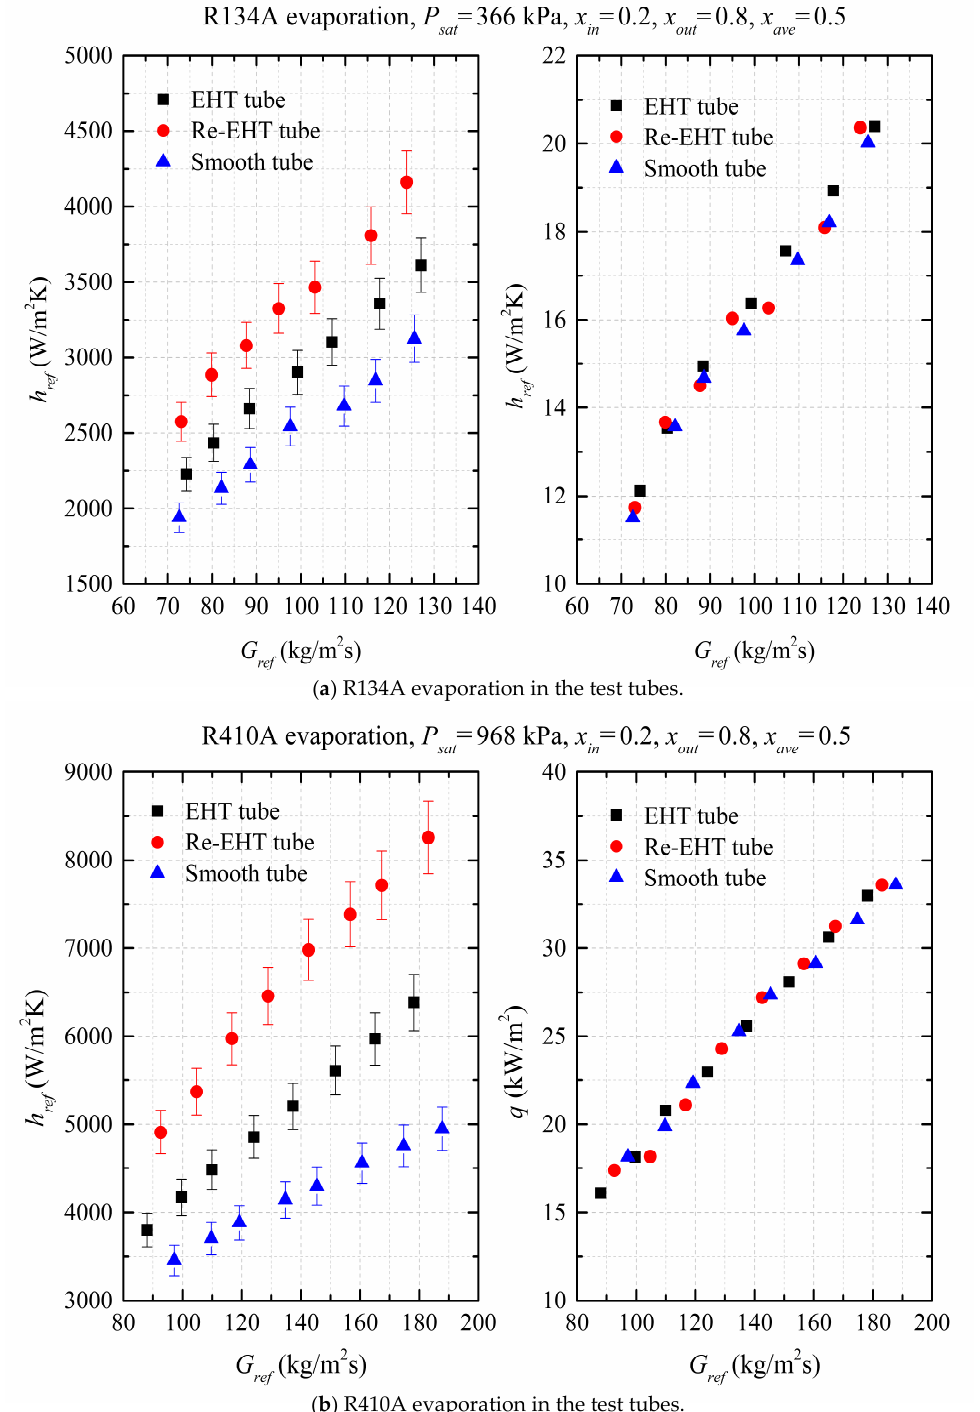
Figure 7. Comparison of flow boiling heat transfer coefficient and heat flux between enhanced and smooth tubes using ( a ) R134A and ( b ) R410A.